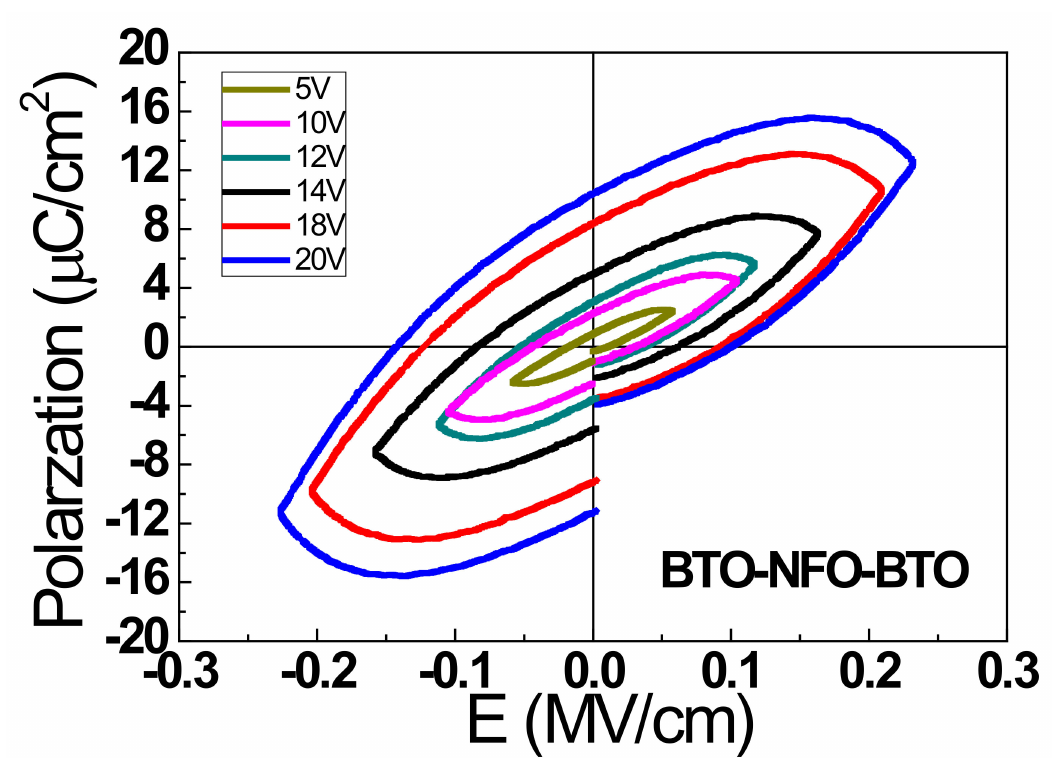
Figure 7. Polarization-Electric Field Hysteresis loop of (BTO/NFO/BTO) tri-layered thin film deposited at room